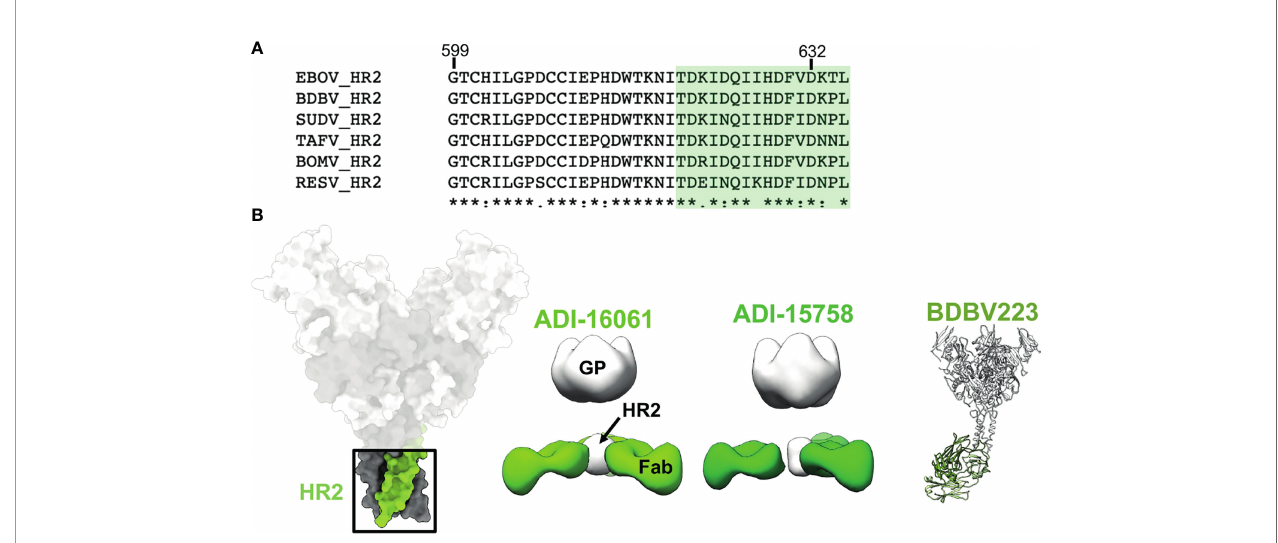
FIGURE 7 | The HR2 domain. (B) The HR2 domain (far left in green) lies at the very base of GP, above the membrane proximal external regions that sit directly above the viral envelope and transmembrane domains. ADI-16061 (left, EMD-8698), ADI-15758 (middle, EMD-6588), and BDBV223 (right, composite of PDBID: 6N7J and PDBID: 5JQ3) bind to overlapping epitopes within the HR2 regions, which lies far below the base of GP. Negative stain EM for each of these antibodies indicates that three Fabs can bind simultaneously to a viral spike. (A) Sequence alignment of the HR2 region from all known ebolaviruses demonstrating the high level of sequence conservation in this region. The BDBV223 peptide is highlighted in